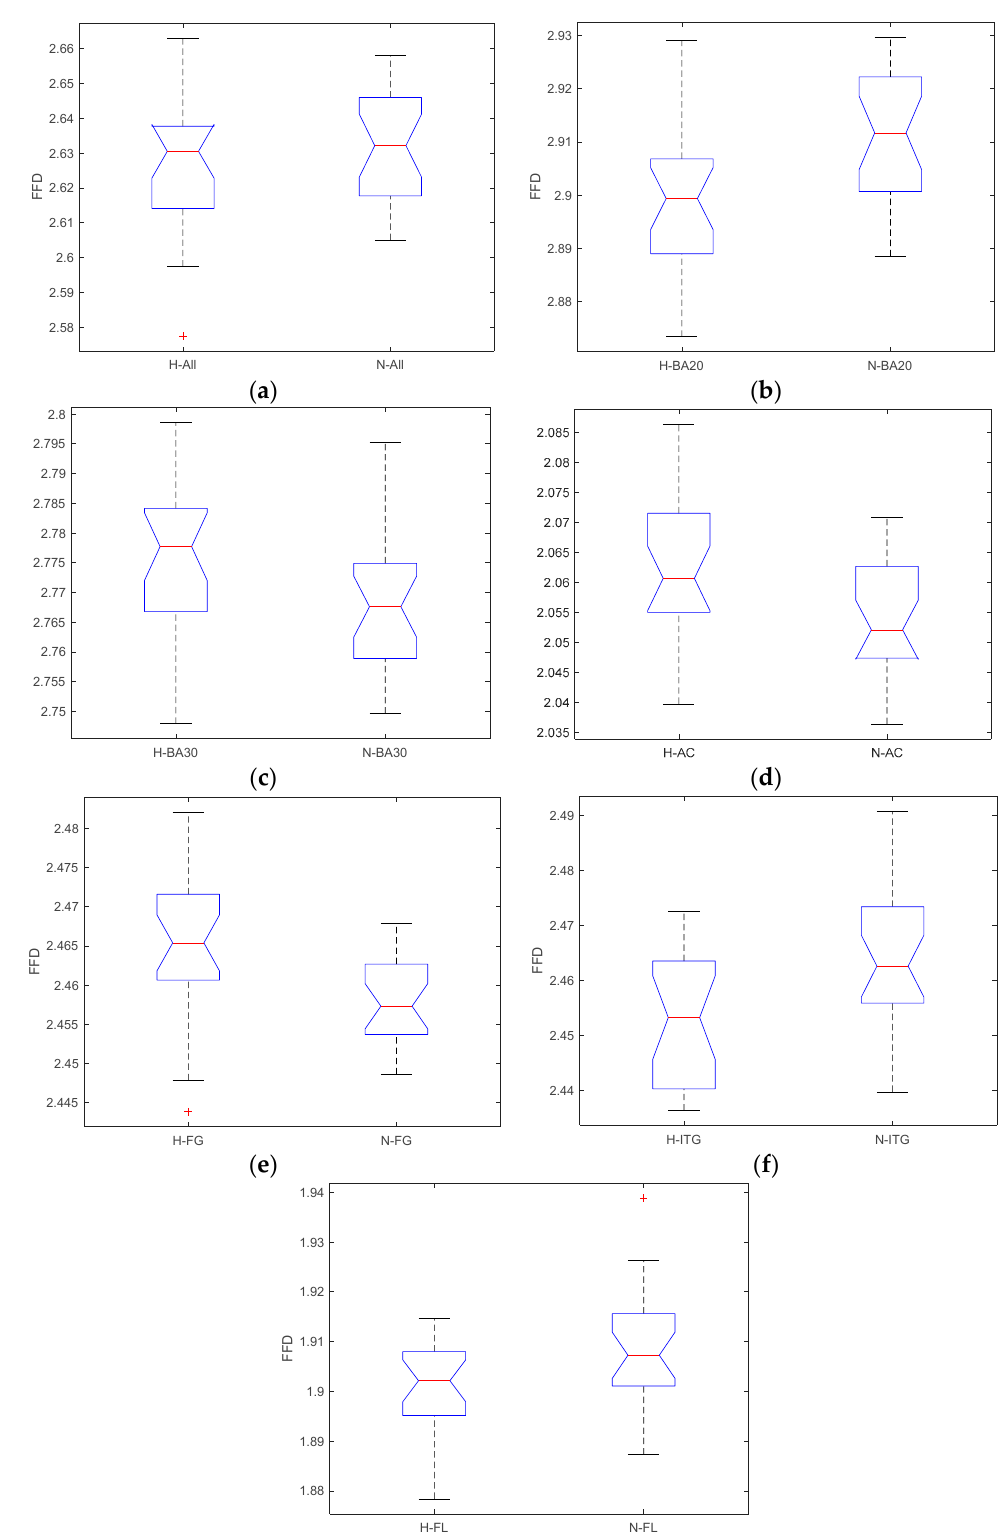
Figure 5. Box-counting FD values for huffaz and non-huffaz measured in the following VOI: ( a ) whole brain structure, ( b ) angular gyrus, and ( c ) middle temporal gyrus. The plus signs (+) indi- cate outliers.